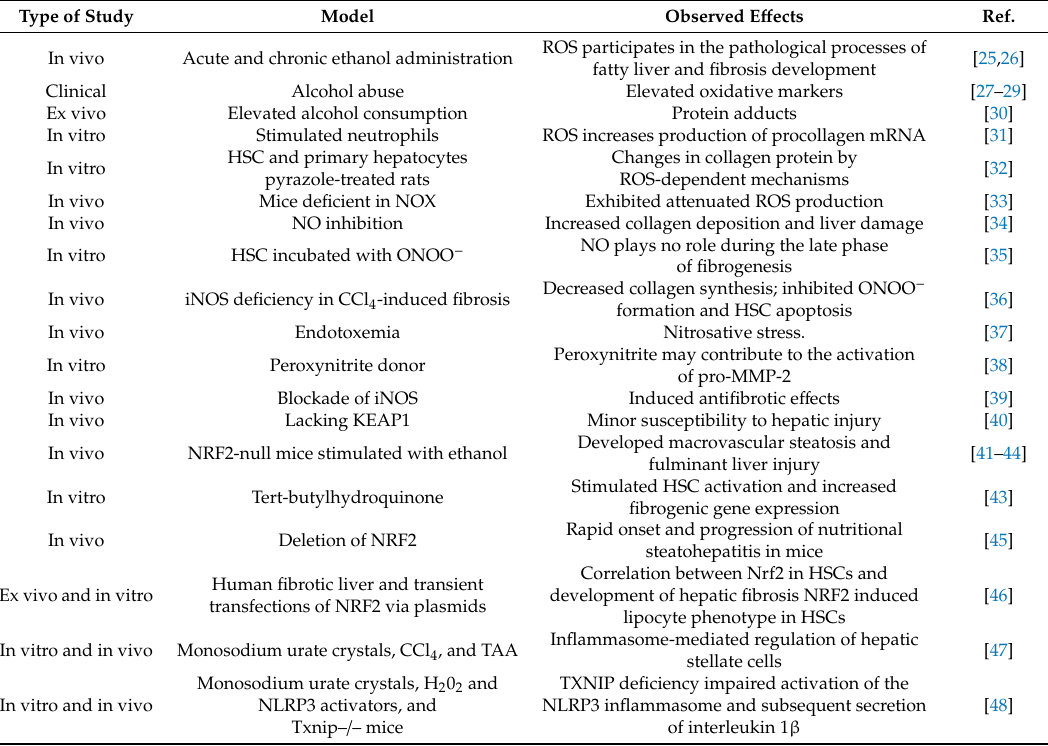
Table 1. A summary of the main studies that associated oxidative stress with liver